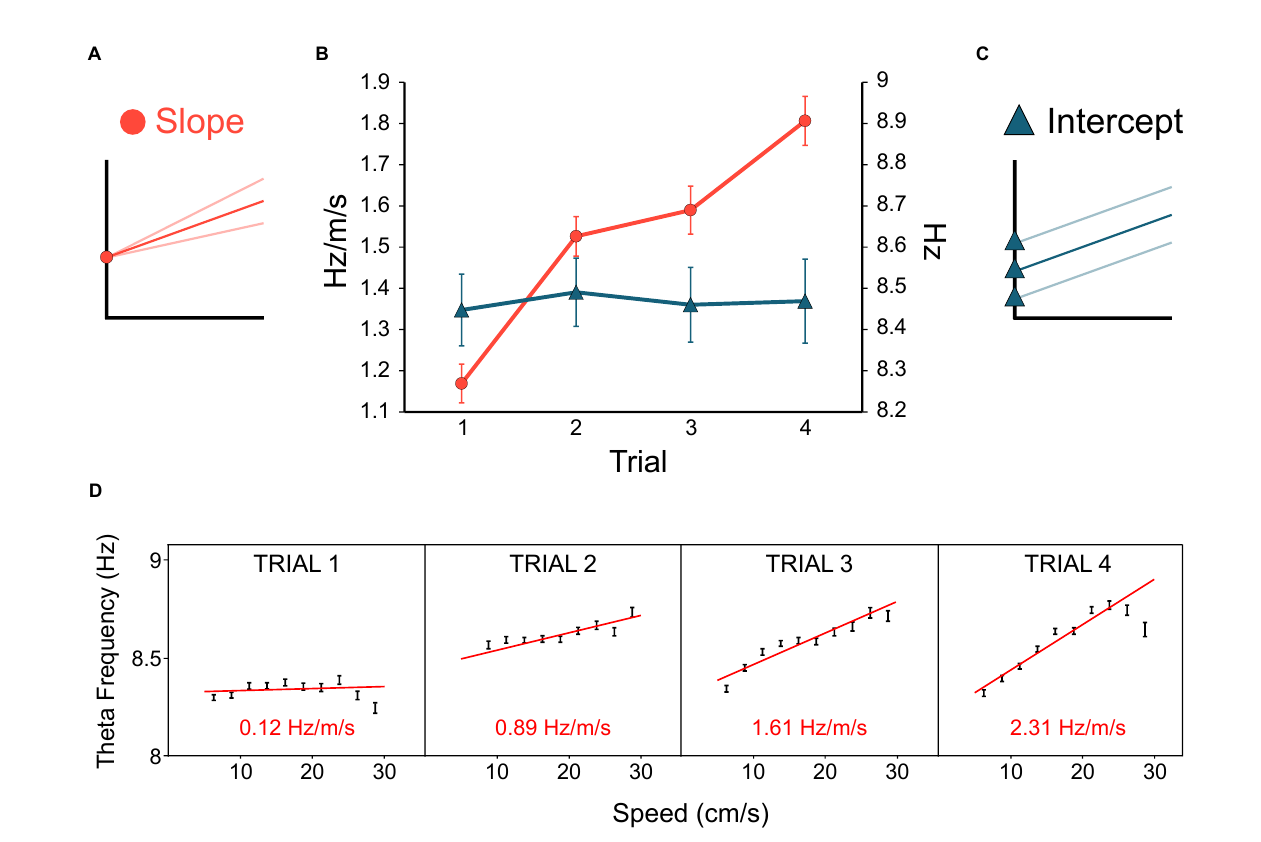
FIGURE6 Novelty flattens theta slope, familiarity increases theta slope. In rats repeatedly exposed to the same environment (inter-trial delay : 20 min, see Methods for details), theta slope (A) was initially flatter on the first trial of the day, then steepened with increasing familiarity with the environment [ (B) , red lines and circles]. In contrast, theta intercept [ (C) , blue lines and triangles] showed no change with the novelty/familiarity dimension (B) . Error bars: ± 1 SEM. (D) A strong-effect example from a single rat over trials 1–4 on day 1 showing theta slope was initially quite flat on trial 1, and steepened over trials. Theta slope values derived from theta frequency to speed regression over 5–30 cm/s running speeds (slopes: red lines; slope values: red text, bottom; speed bins: 2.5 cm/s). In summary, novelty reduced theta frequency by selectively reducing the gain of the theta-frequency-to-stimulus-rate contribution to theta